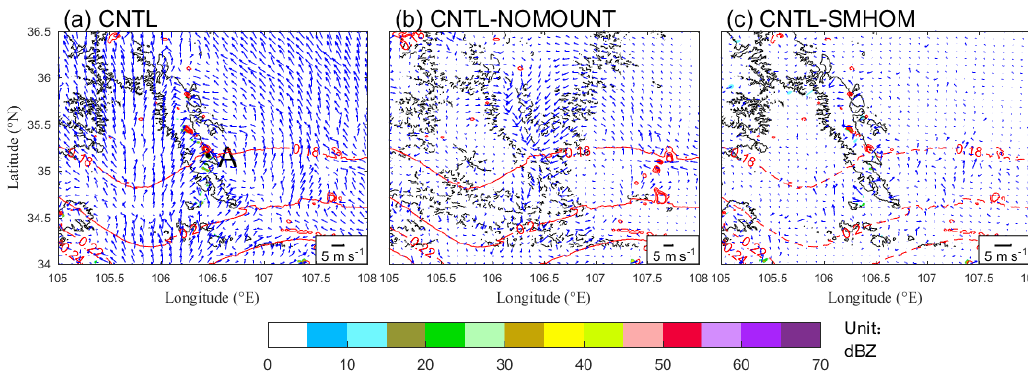
Figure 7. Simulated radar composite reflectivity (shaded, units: dBZ), wind field (blue vector, units: m s −1 ), and 7 cm-soil moisture (red solid lines in ( a ) and ( b ), and red dashed lines in ( c ), units: m 3 m − 3 ) at 0920 LST. ( a ) CNTL, ( b ) NOMOUNT, and ( c ) SMHOM. The wind shown in ( a ) is the 10 m wind from CNTL, in ( b , c ) are the differences of 10 m wind field between CNTL and the corresponding sensitivity tests. The solid black lines are 2000 m topographic contours, the dash black lines in ( b ) are 1500 and 2000 m topographic contours of CNTL.